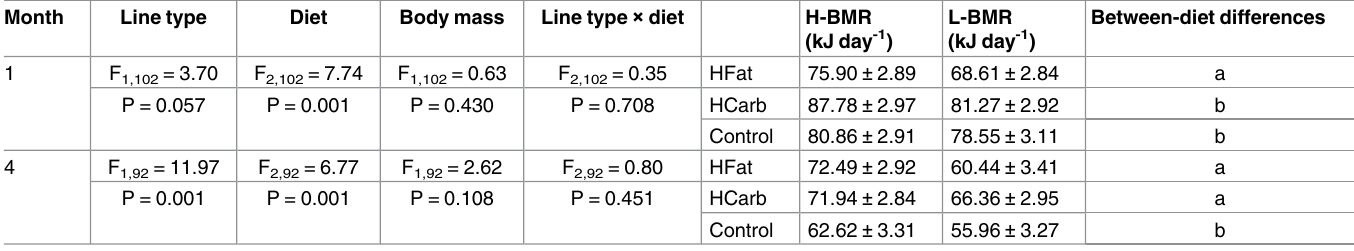
Table 1. ANCOVA results and mean values for energy assimilation (least square means ± s.e.m) measuredin the first and fourth month of the experiment in H-BMR and L-BMR type mice fed a HCarb, HFat and Control diet. Significantbetween-diet group differences are marked by different let- ters